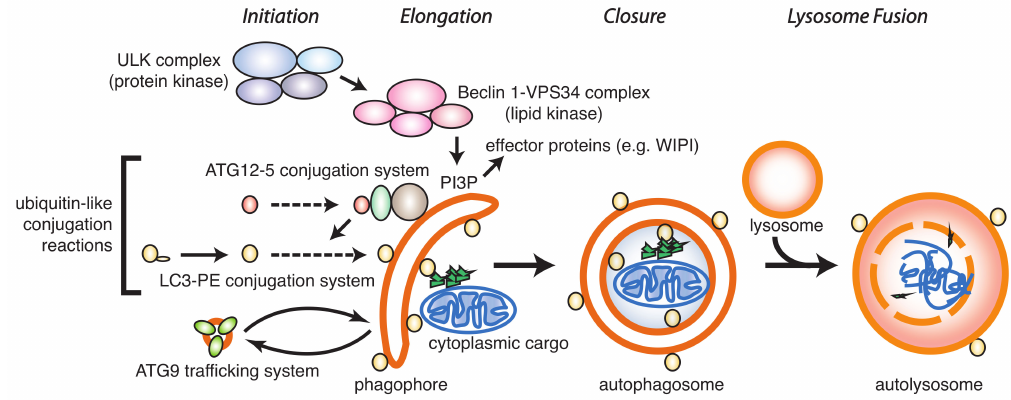
Figure 1. Key components in the autophagy pathway. Autophagy is initiated by the ULK protein kinase complex, leading to activation of the Beclin-1–VPS34 complex and generation of phosphatidyl-inositol-3-phosphate (PI3P). PI3P serves as a recognition domain in the phagophore membrane for recruitment and assembly of other protein complexes such as the WD-repeat protein interacting with phosphoinositides (WIPI) proteins. These early events lead to activation of a series of ubiquitin-like conjugation reactions, including ATG12-5 formation and LC3 / GABARAP processing. Recruitment of cargo to the phagophore and closure of the autophagosome is followed by fusion with the lysosome and degradation of cargo in the